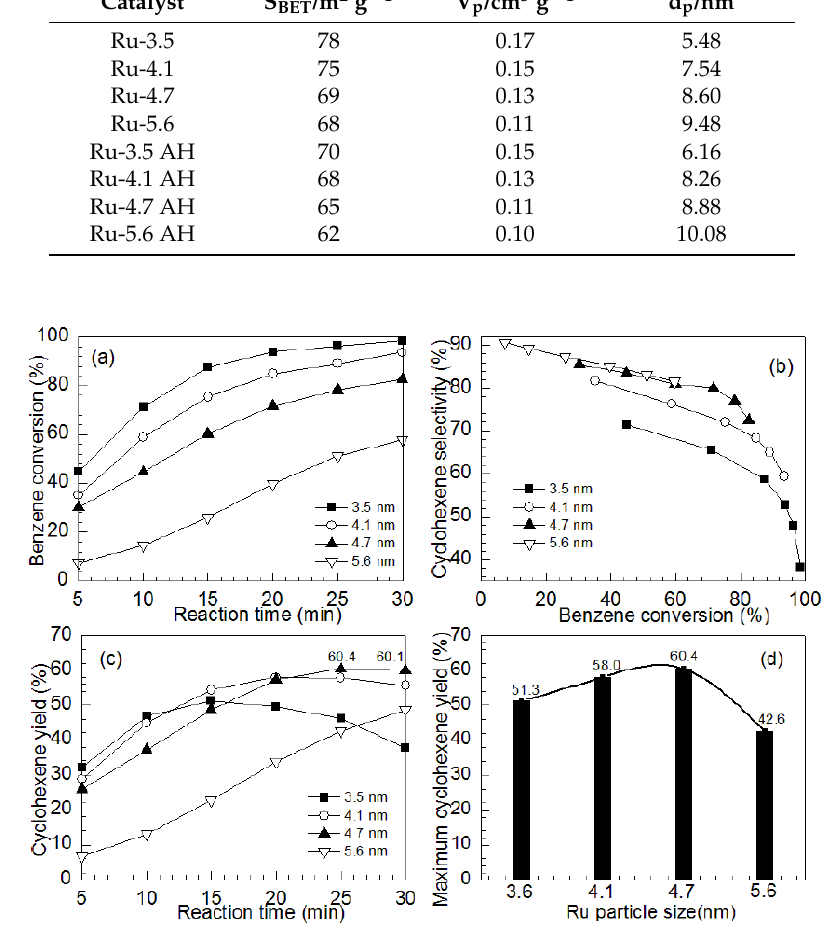
Figure 12. Reaction course of benzene hydrogenation over the Ru-4.7 catalyst under the optimized condition ( m cat = 2.0 g, m ZnO = 0.3 g, m ZnSO4 = 50.0 g, v H2O = 280 mL, v benzene = 140 mL, T = 423 K, p H2 = 5.0 MPa). To obtain a deeper understanding of the mechanism regarding how the particle size of Ru affects the cyclohexene formation, Ru-3.5 AH, Ru-4.1 AH, Ru-4.7 AH and Ru-5.6 AH were tested for